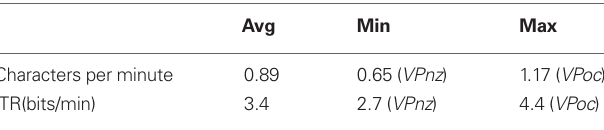
Table 2 | Spelling speed in the online condition, averaged over both sentences.